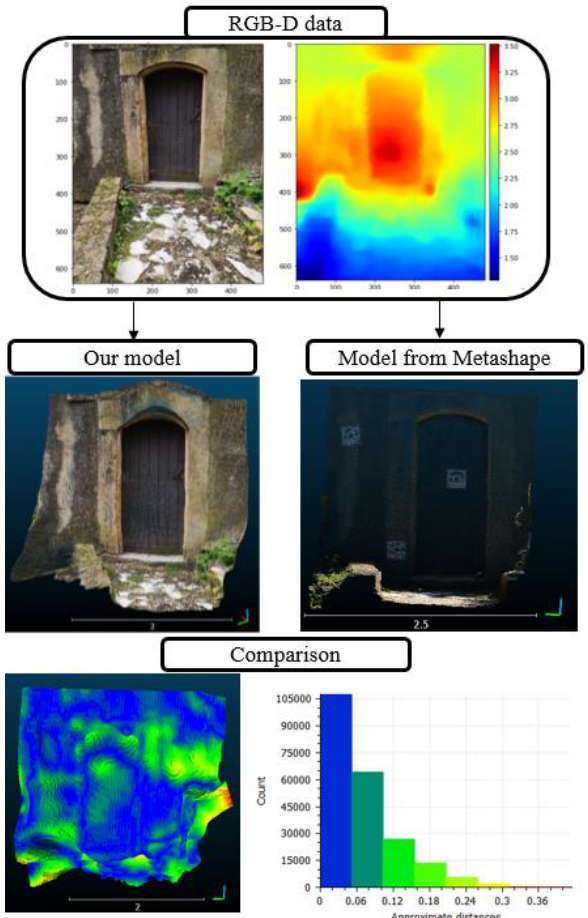
Figure 8. Qualitative analysis of a resulting point cloud